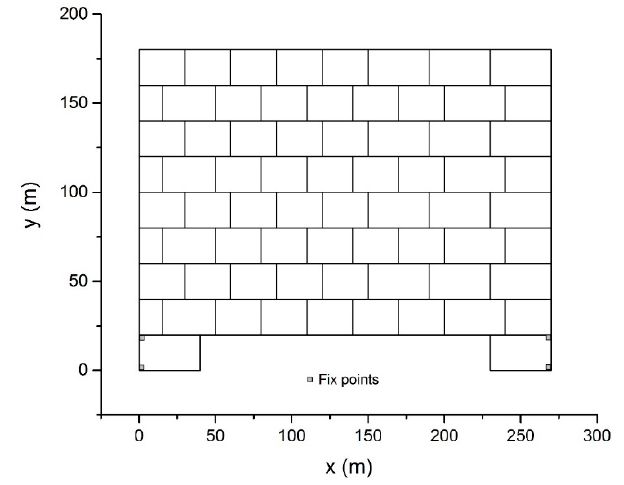
Materials 2021 , 14 , x FOR PEER REVIEW Figure 11. The block wall model. Figure 11. The block wall model.